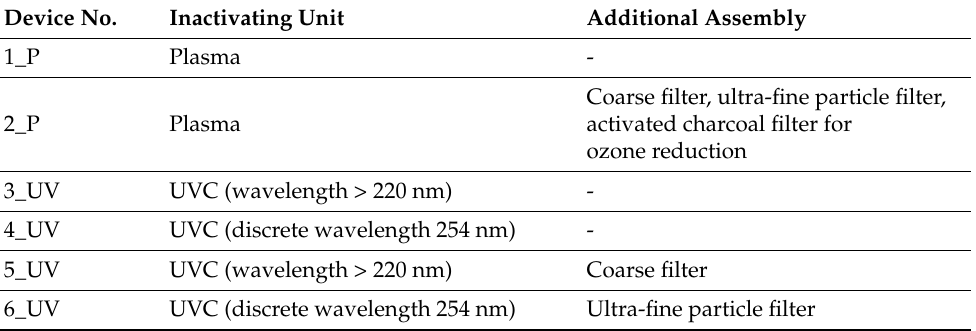
Table 1. Investigated air